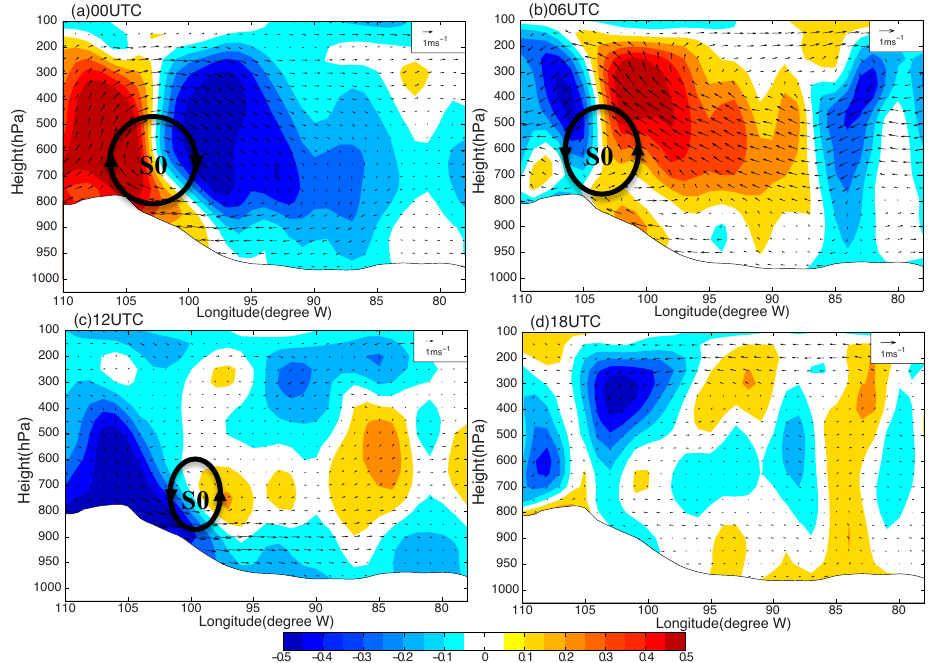
Figure 7 . Similar to Fig. 6 but for the averages over the focus domain in North America.